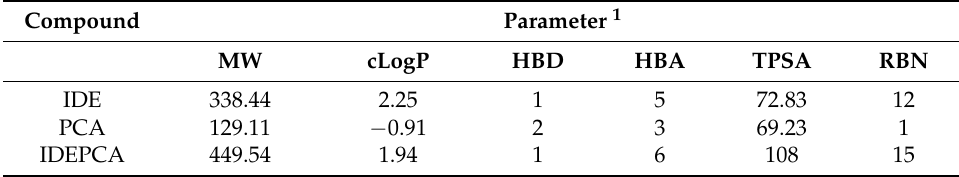
Table 1. Physico-chemical properties and molecular descriptors of idebenone (IDE), pyroglutamic acid (PCA), and idebenone ester with pyroglutamic acid